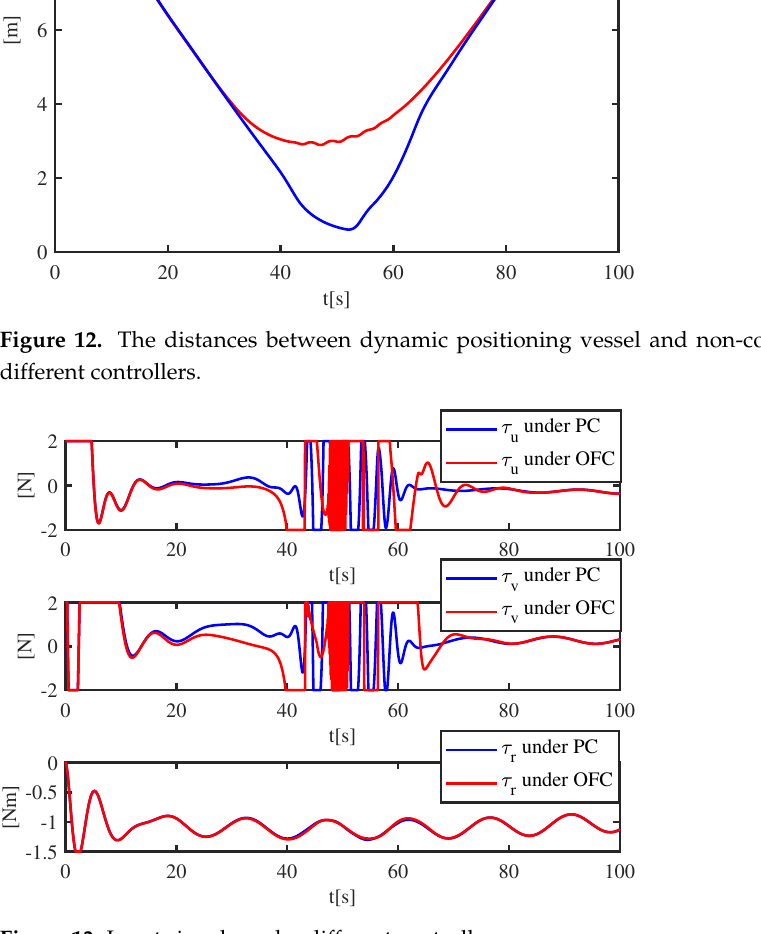
Figure 13. Input signals under different